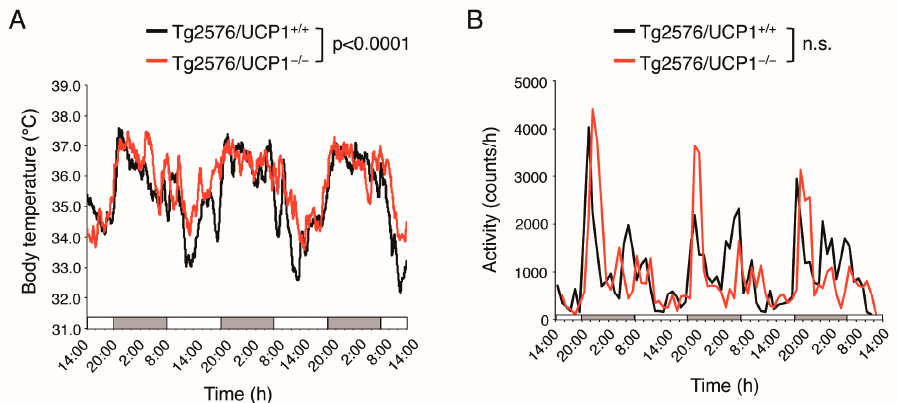
Figure 1. UCP1 deletion in Tg2576 mice increases core body temperature at 23 °C. ( A ) Circadian rhythms of average core body temperature and ( B ) circadian rhythms of physical activity in Tg2576/UCP1 +/+ and Tg2576/UCP1 -/- mice were analyzed using the VitalView system at 15 months of age. The results shown are mean ± SD, and significant differences between two groups were assessed by repeated measures ANOVA. n.s., no significant difference.